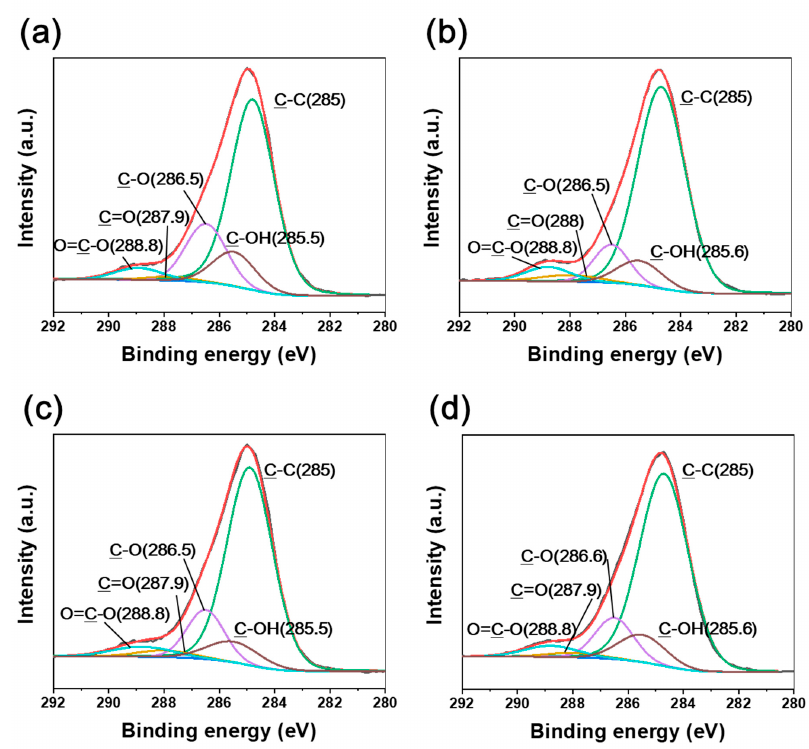
Figure 8. C1s XPS spectra of CF irradiated at ( a ) 3.4 kGy/s, ( b ) 6.8 kGy/s, ( c ) 13.5 kGy/s, and ( d ) 27 kGy/s absorbed dose rates. Polymers 2020 , 12 , x FOR PEER REVIEW